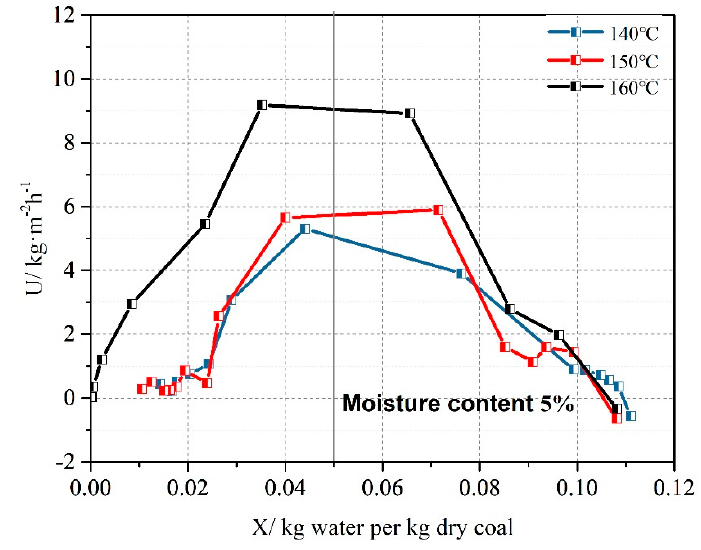
Figure 7. Drying rate of the thin-layer drying experiment of 2 cm thick coal.